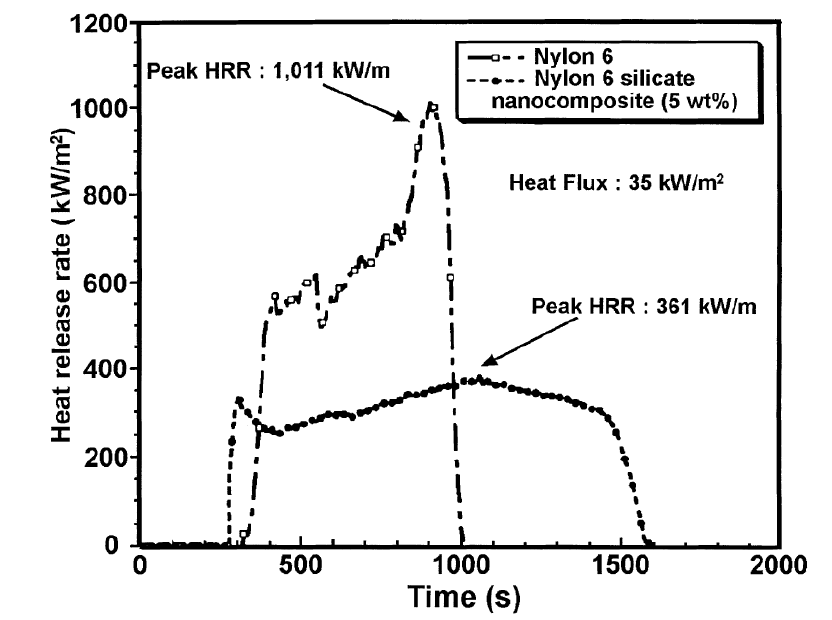
Figure 47. Comparison of the HRR for pure nylon 6 and nylon 6 nanocomposites containing 5 wt% of the filler. Reproduced from referebce [170] with permission from